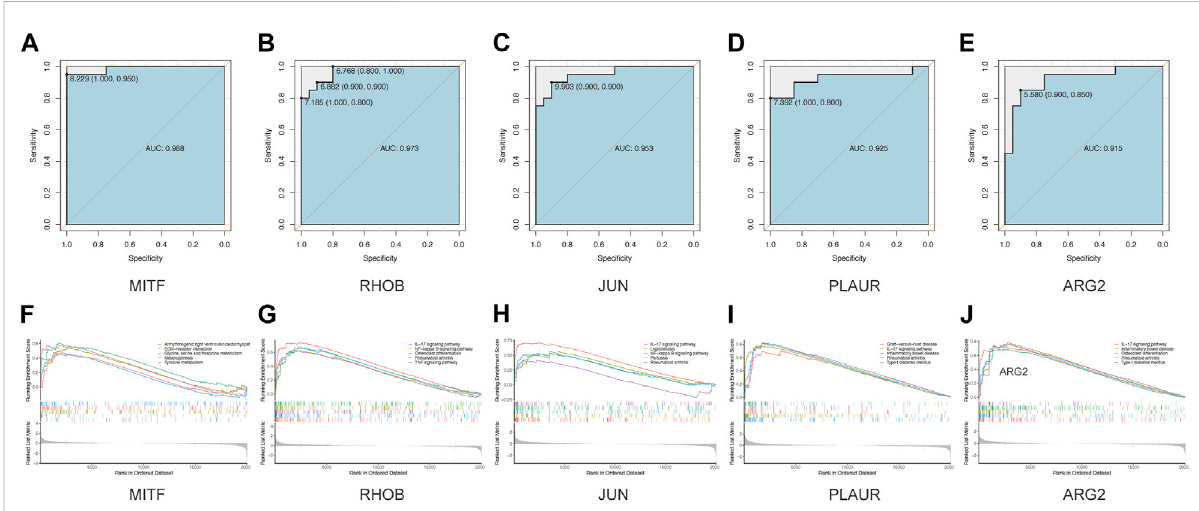
FIGURE 8 GSEAanalysesandROCcurvesofhubgenes. (A – E) .TheperformanceofusinghubgenestopredictAAK:MITF-AUC:0.988;RHOB-AUC:0.973; JUN-AUC:0.953; PLAUR-AUC:0.925; ARG2-AUC:0.915. (F – J) GAES analysis showed that Arrhythmogenic right ventricular cardiomyopathy, ECM − receptor interaction, Glycine, serine and threonine metabolism Melanogenesis, and Tyrosine metabolism. FOSB enriched in IL − 17 signaling pathway Legionellosis, Osteoclast differentiation, Rheumatoid arthritis, and TNF signaling pathway. JUN enriched in IL − 17 signaling pathway, Legionellosis, NF − kappa B signaling pathway, Pertussis, and Rheumatoid arthritis. PLAUR enriched in Graft − versus − host disease, IL − 17 signaling pathway, In fl ammatory bowel disease, Rheumatoid arthritis, and Type I diabetes mellitus. ARG2 enriched in IL − 17 signaling pathway, In fl ammatory bowel disease, Osteoclast differentiation, Rheumatoid arthritis, and Type I diabetes mellitus.